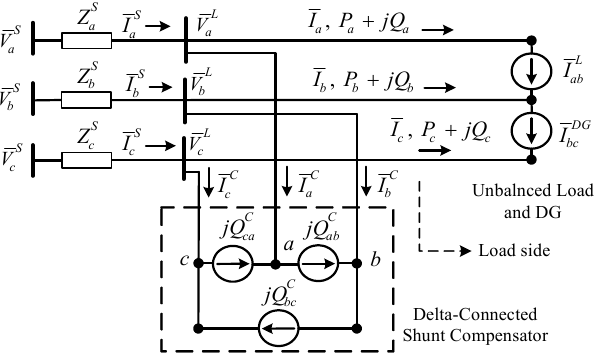
Figure 5. System for deriving the compensation scheme.